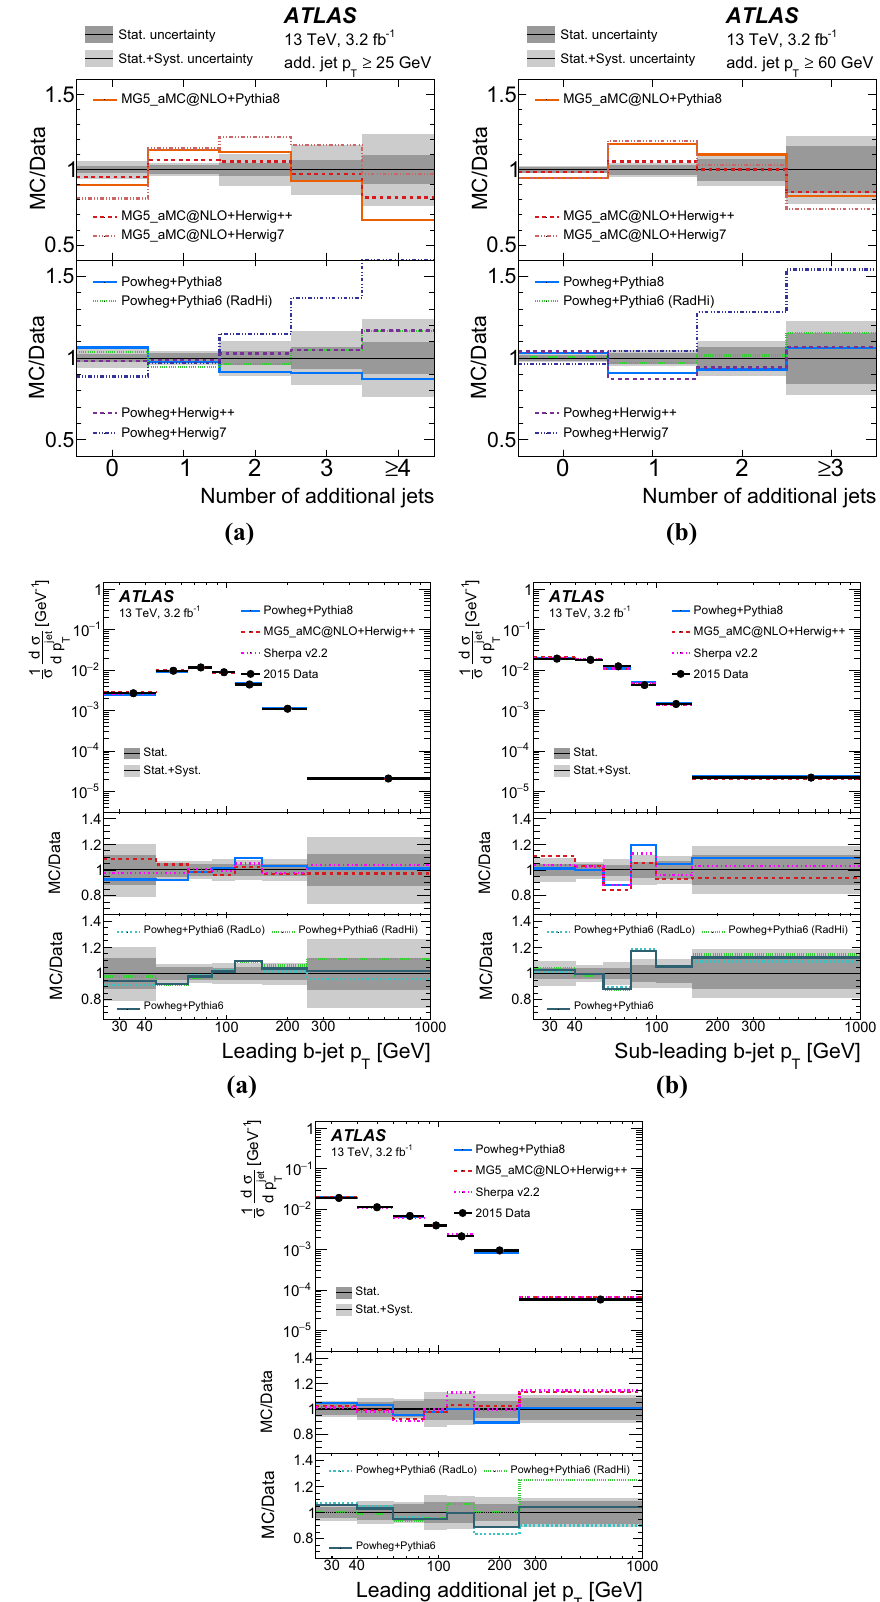
Fig. 5 Ratios of jet multiplicity distribution for different p T thresholds of the additional jets predicted by various MC generators to the unfolded data, for a additional jet p T > 25 GeV, b additional jet p T > 60 GeV. The shaded regions show the statistical uncertainty ( dark grey ) and total uncertainty ( light grey )